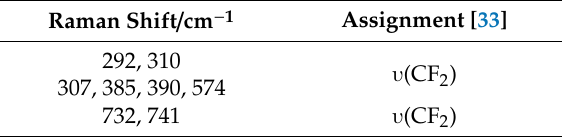
Table 4. Assignment of major Raman bands of